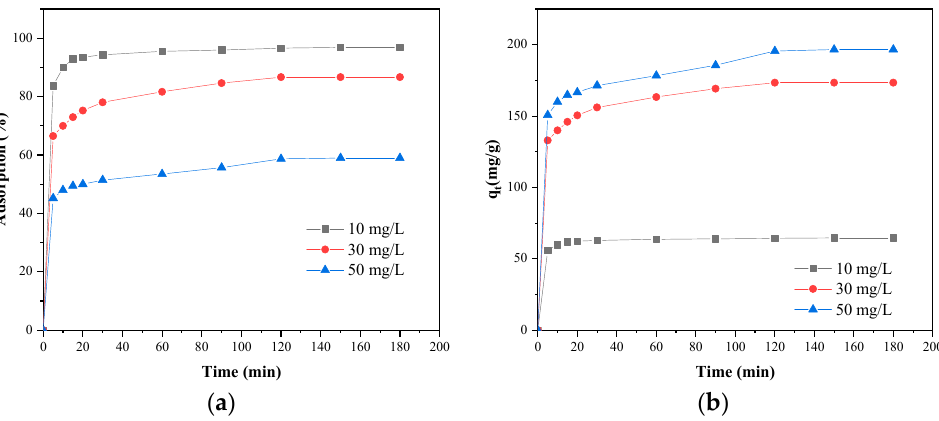
Figure 8. Effect of contact time on adsorption of MB on SLS-C at pH = 5.0, S/L = 0.15 g·L − 1 . ( a ) The Figure 8. E ff ect of contact time on adsorption of MB on SLS-C at pH = 5.0, S / L = 0.15 g · L − 1 . ( a ) The adsorption rate; ( b ) the adsorption capacity. adsorption rate; ( b ) the adsorption